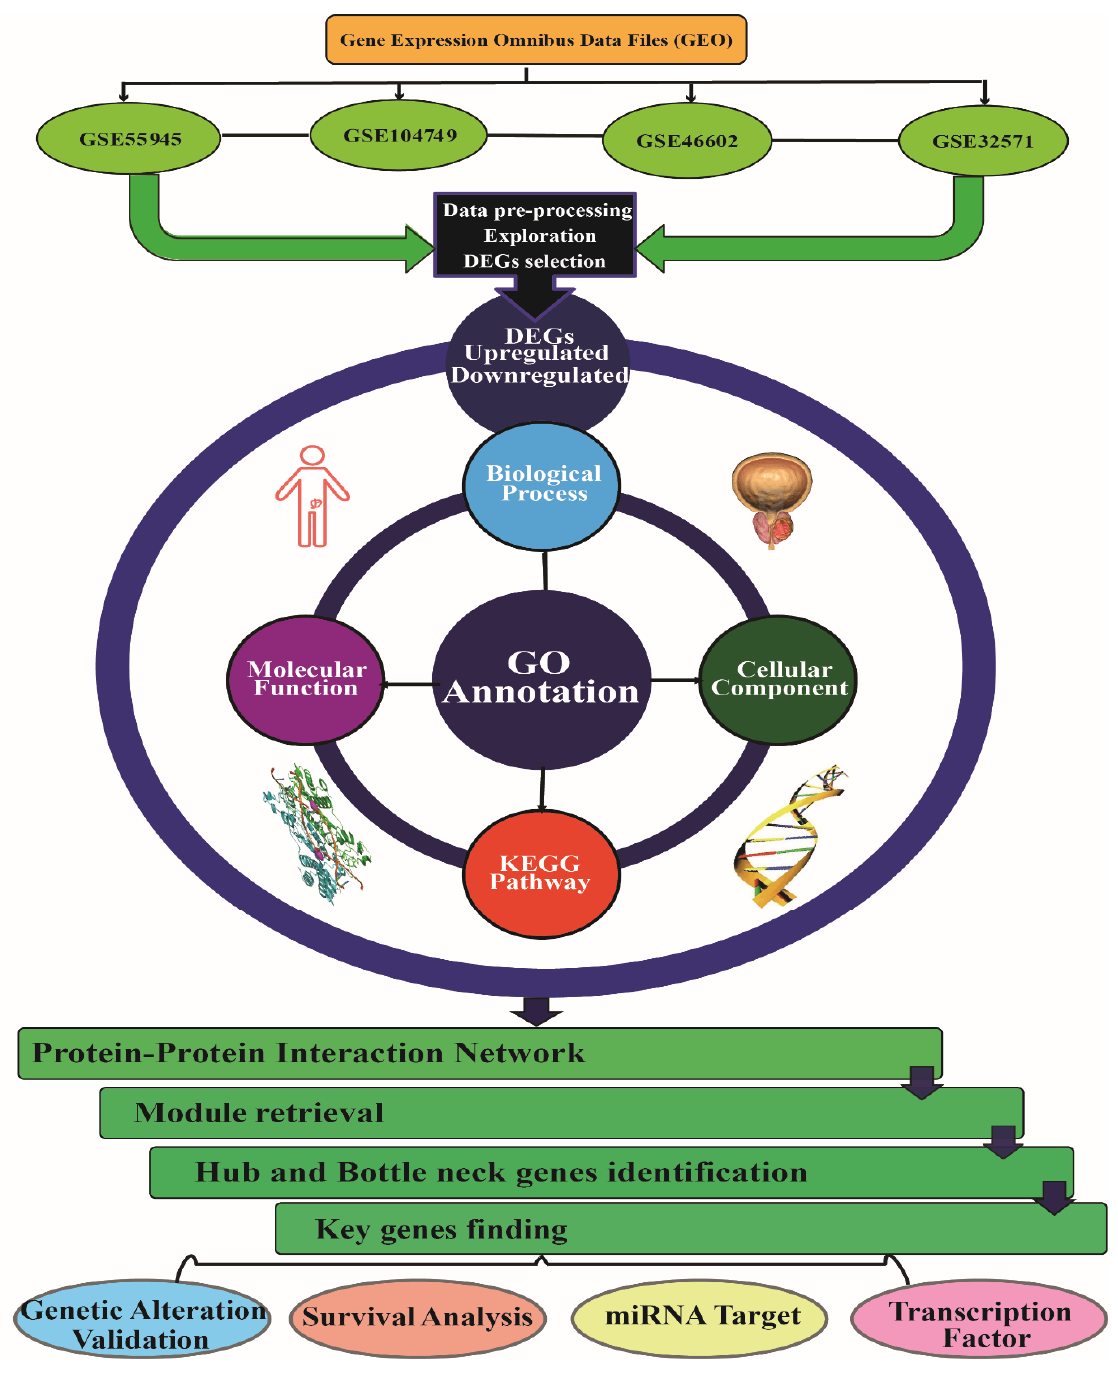
Figure 1. Flowchart of methodology containing sorting of GEO datafile, selection of DEGs, GO annotation analysis, and identification of key genes. DEGs (differentially expressed genes), GEO (gene expression omnibus), GO (gene ontology).